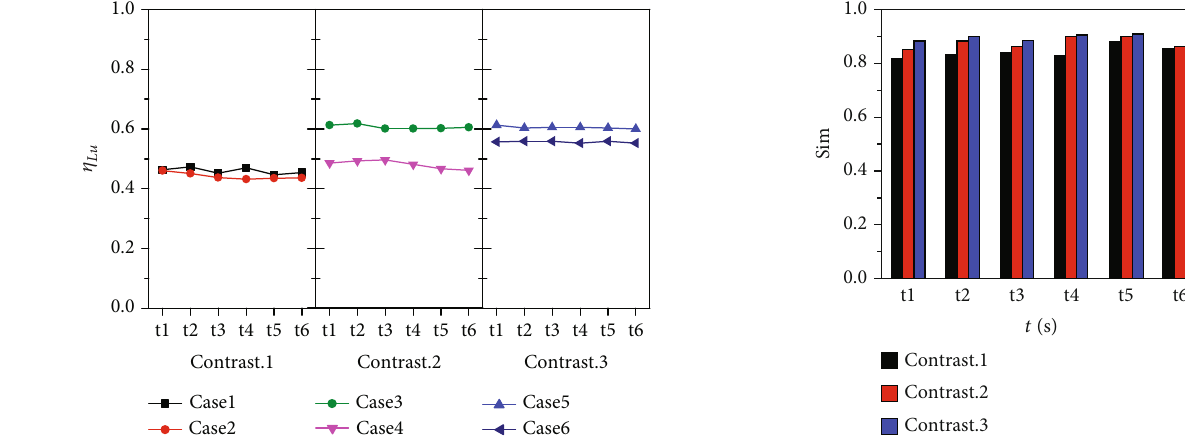
Figure 13: Comparative results of dimensionless icing superior limits.